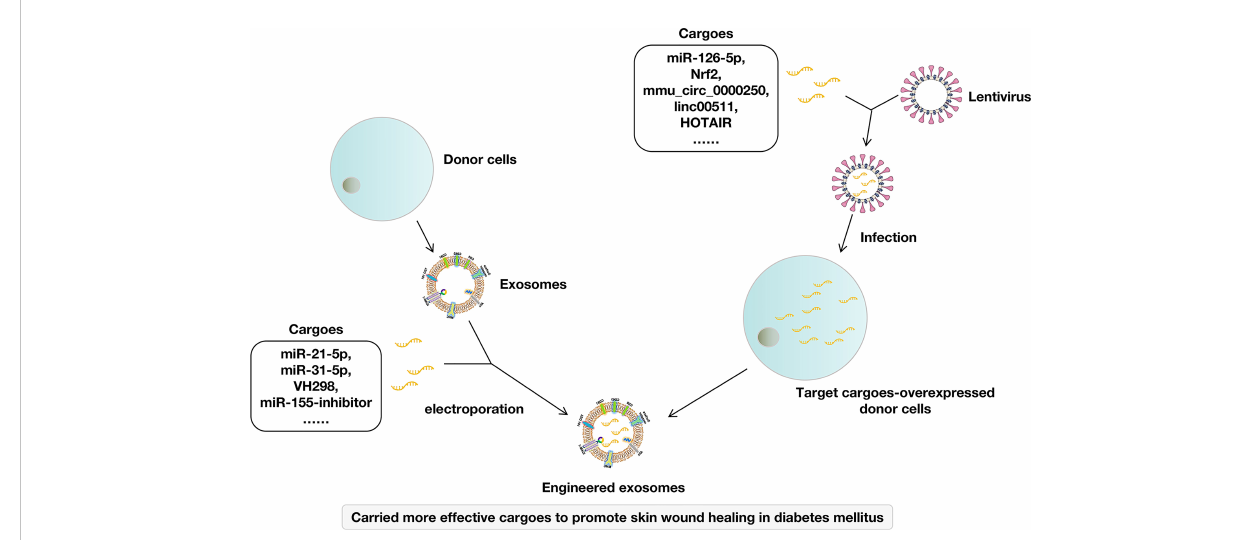
FIGURE 2 Engineering exosomes for skin wound healing in diabetes